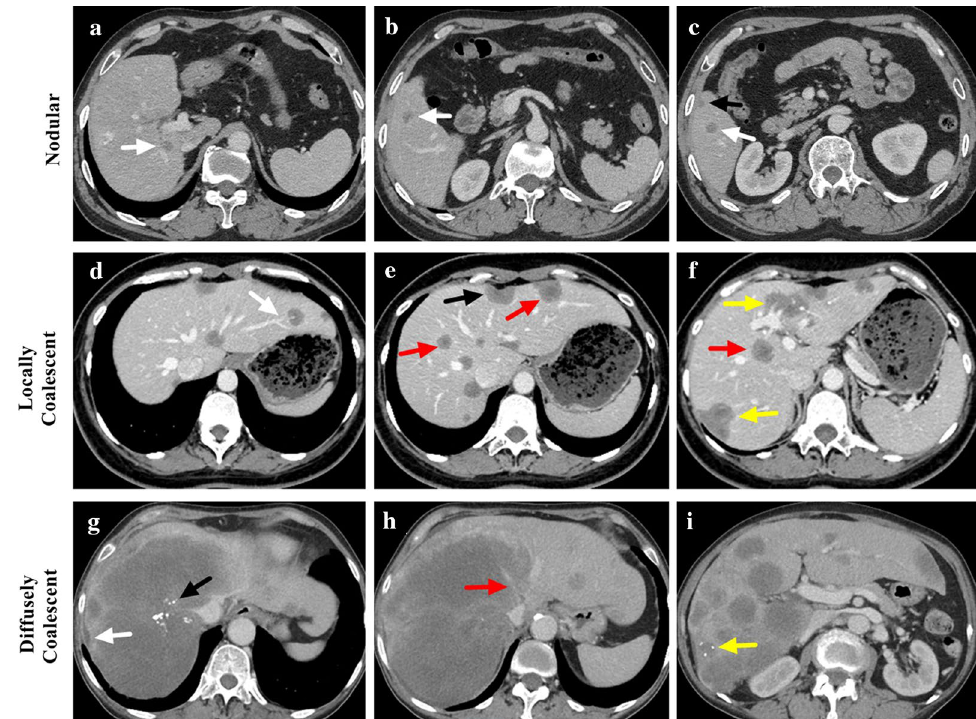
Fig. 5 a–c Contrast-enhanced CT scan of a 44-year-old male HEH patient in nodular group. Multiple intrahepatic nodular lesions could be found (marked with white arrows) with one subcapsular lesion (marked with a black arrow). No target sign or lollipop sign was detected. d–f Contrast-enhanced CT scan of a 32-year-old female HEH patient in locally coalescent group. Locally coalescent lesions could be found (marked with yellow arrows). A subcapsular lesion caused capsular retraction (marked with a black arrow). Both target sign (marked with red arrows) and lollipop sign (marked with a white arrow) could be detected. g–i Contrast-enhanced CT scan of a 68-year-old female HEH patient in diffusely coalescent group. Right hepatic vein disappeared, and middle hepatic vein was involved by the diffusely coalescent lesion (marked with a red arrow). Both capsular retraction (marked with a white arrow) and calcification (marked with a black arrow) could be detected. One subcapsular lesion with calcification and capsular retraction was marked with a yellow arrow